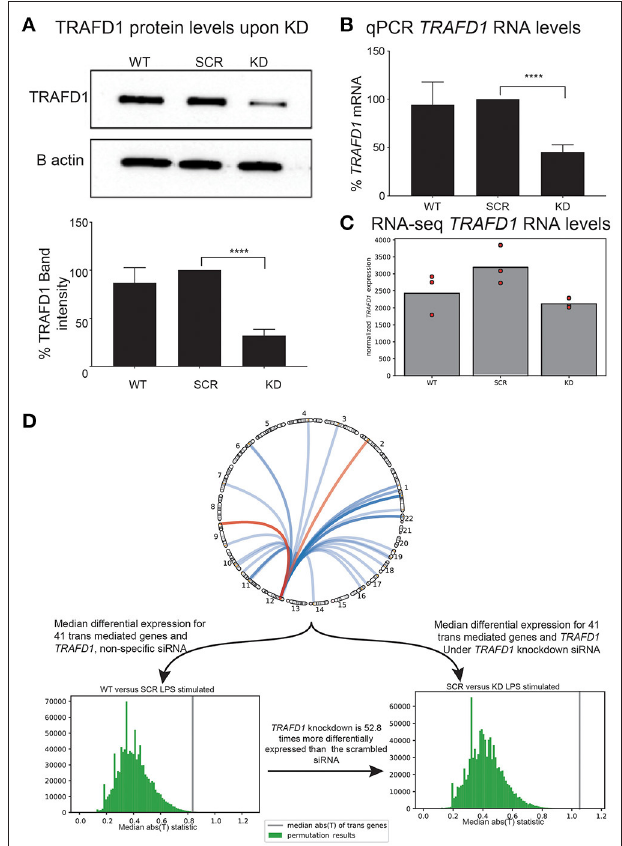
FIGURE 4 | In vitro knockdown of TRAFD1 validates trans -mediation network. THP-1 cell line based knockdown of TRAFD1 (KD) compared to non-specific siRNA (SCR) and untransfected cells (WT) (A) Western blot based protein levels of TRAFD1 compared to the B actin control. p ≤ 0.0001 (****). (B) qPCR RNA levels and (C) RNA-seq levels of TRAFD1 expression. (D) Comparative differential expression experiment of TRAFD1 , comparing the 41 trans -mediated genes and TRAFD1 differential expression in the WT vs. SCR to the SRC vs. KD in the LPS stimulated condition. The WT vs. SCR is 52.8 times less differentially expressed as the SCR vs. KD, indicating that TRAFD1 KD affects these 41 genes in trans